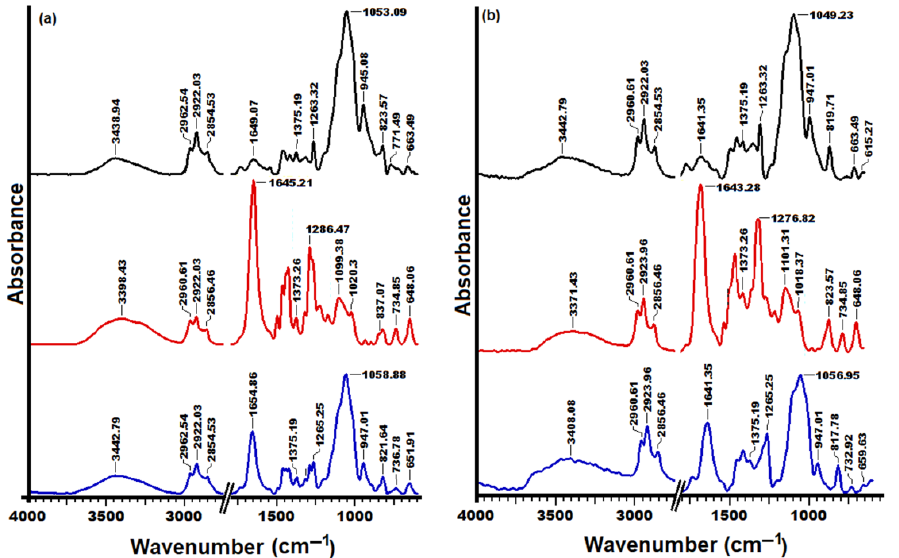
Figure 5. FTIR spectra of free ( a ) and embedded with AgNPs ( b ) HPMC (black), PVP (red), 70 HPMC/30 PVP (blue)